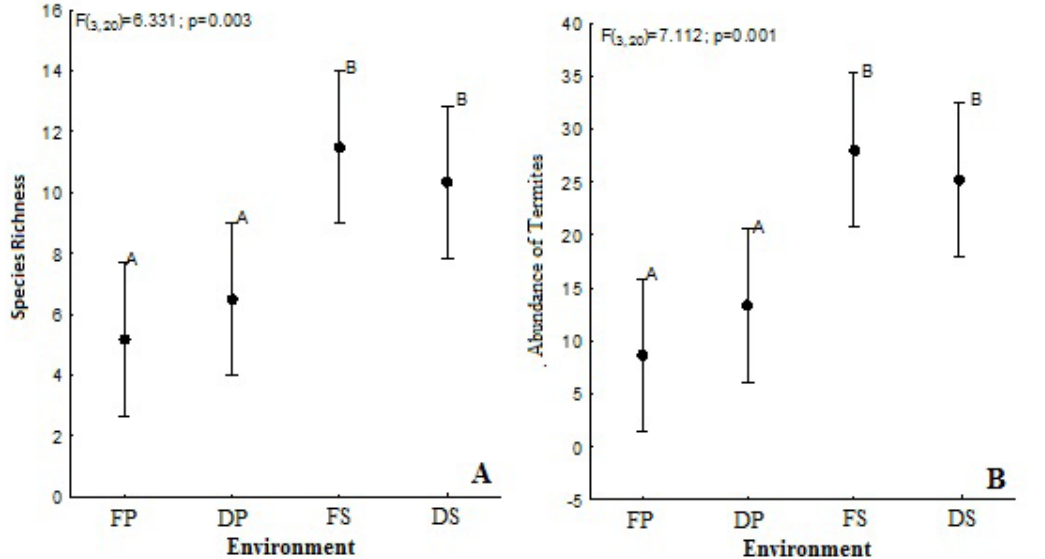
Fig 2 . Demonstration using GLM analisys of richness of termite species based on environments (A) and abundance of termites based on different environments (B) in the town of Cáceres, MT. FP - flooded pasture, DP - dry pasture, FS - flooded savanna and DS - dry savanna